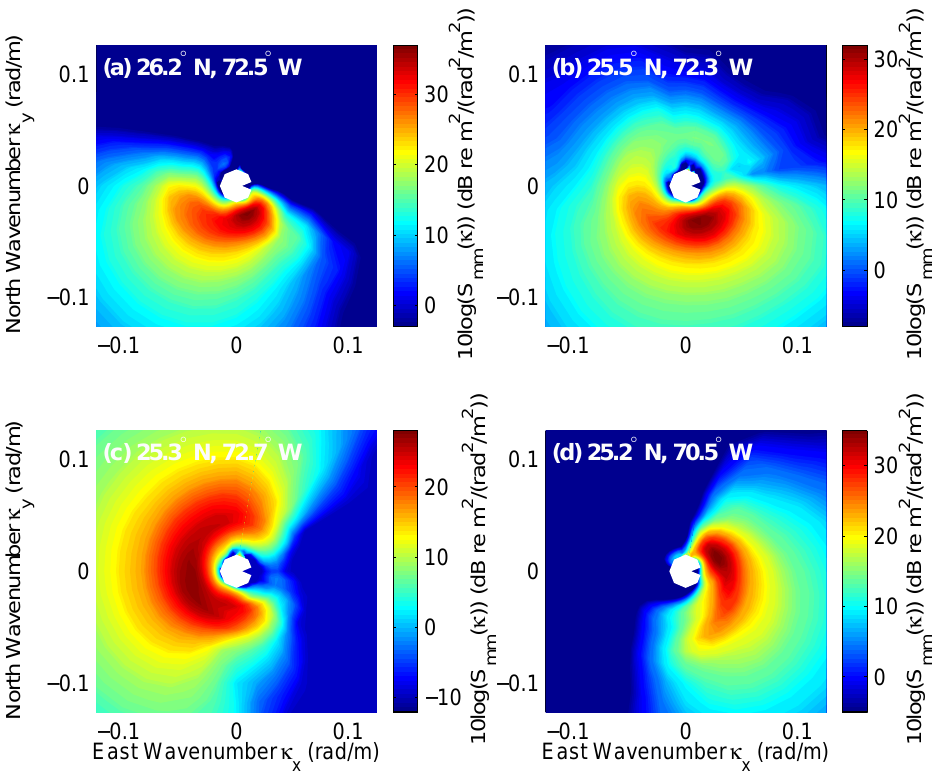
Figure 2. The wave height power spectral level (10log S mm ( κ ) /(m 2 /(rad 2 /m 2 ))) in dB re m 2 / ( rad 2 /m 2 ) at the locations of interest ( a – d ) given in Figure 1 at 1200 on 24 August 1998. The peak in the spectra is at roughly κ = 0.04 rad/m or σ = 0.63 rad/s which corresponds to an acoustic frequency of ω = 1.26 rad/s or f = 0.2 Hz. At some locations ( b – d ) there are waves propagating with opposing wavenumber vectors κ , while at other locations ( a ), most of the waves propagate in the same direction. From Equation (37) we expect these locations with opposing waves to produce the greatest microseismic source levels and shown in Figure